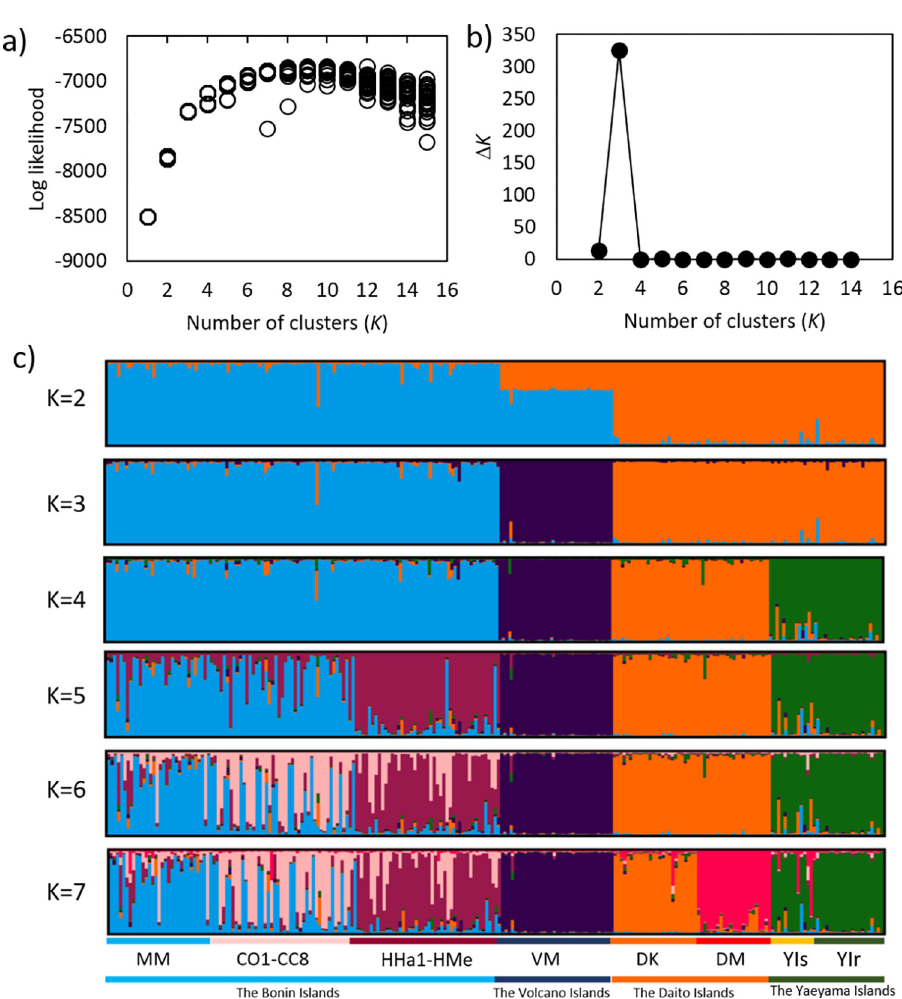
Fig 6. Results of STRUCTURE analysis for all Planchonella obovata s . l . populations based on 11 SSR markers. Forty-five samples from the Chichijima and Hahajima Islands were selected at random. Changes in loglikelihood and Δ K as the number of clusters ( K ranging from 1 to 15), barplots of 241 genotypes at K = 2 to 9. Vertical columns represent individuals; heights of bars are proportional to the posterior means of the estimated admixture proportions. In a comparison of the five three-population divergence models, Model3 was the best model, with a posterior probability of 0.431 (Fig 2B, Table 2). However, votes of Model1 (0.265) was not low compared with those of Model3 (0.369), and the error rate was also rela- tively high (0.388). This high error rate was due to the high classification error rate of Model5, as shown in the confusion matrix (0.646; S5 Table in S1 File). Thus, we removed Model5 and compared the remaining four models. In this comparison, although Model3 was again selected as the best model, and the error rate was reduced (0.295), the posterior probability was still not high (0.516), and the votes of Model1 were also still not low (0.352) compared to those of Model3 (0.429) (Table 2). As the votes for the other two models were low (0.117 for Model2 and 0.102 for Model4), we removed these two models and compared only Model1 and Model3. In this comparison, Model3 was again selected as the best model, and had a high pos- terior probability (0.752) and a low error rate (0.184) (Table 2). Therefore, we confirmed that Model3 was the best model among the five three-population divergence models. Using the